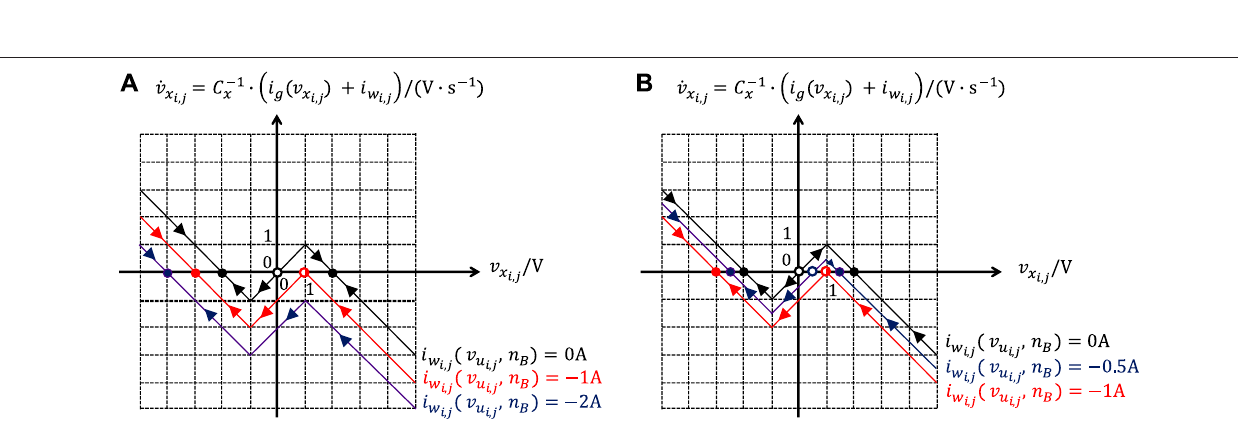
Figure 6B , illustrating the dynamic route of the cell state for ( v , n ) (cid:1) − 0 . 5 · ( a i w u i , j B i , j